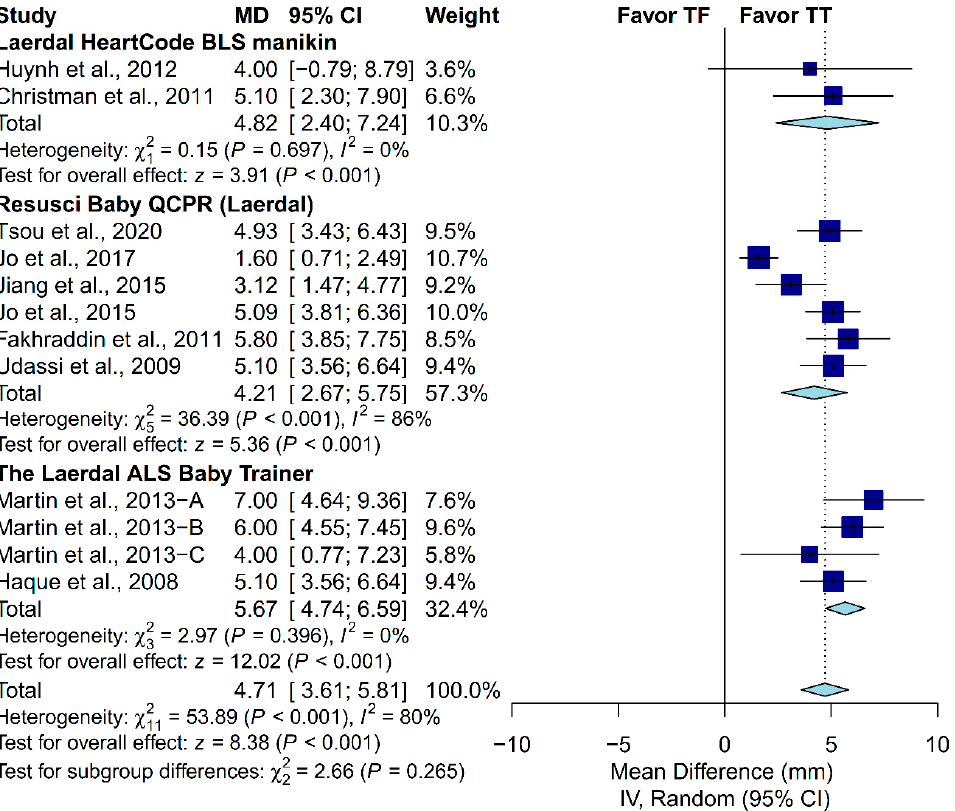
Figure 6. Subgroup analysis of chest-compression depth grouped by manikin model.